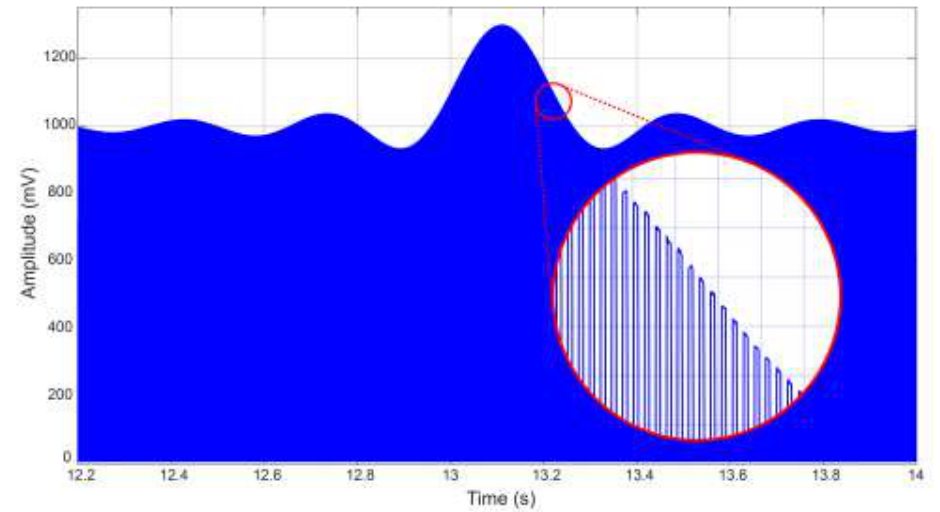
Figure 4. Acquired m ( t ) input signal for a 3.5 Hz bandwidth sinc ( t ) at a f lock − in of 2 kHz. Within the highlighted circle a zoomed portion of the modulated signal is shown.